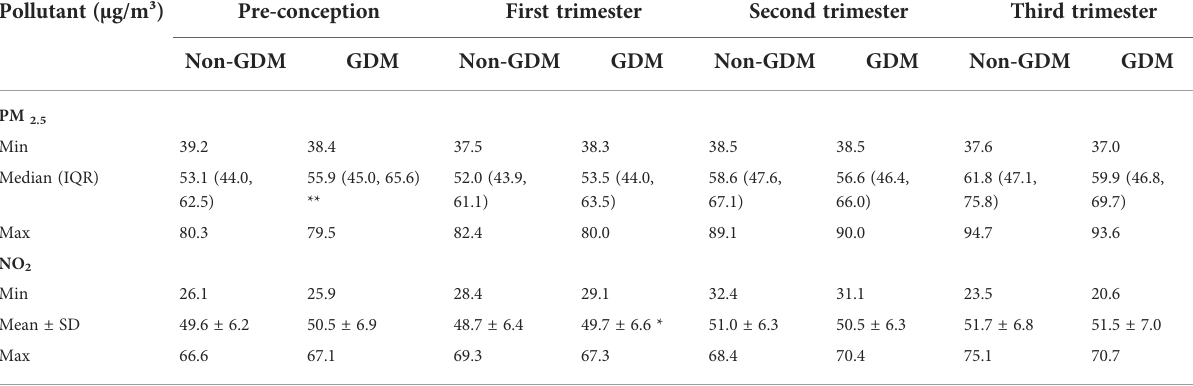
TABLE 4 Exposure estimate data of PM 2.5 and NO 2 using the LUR